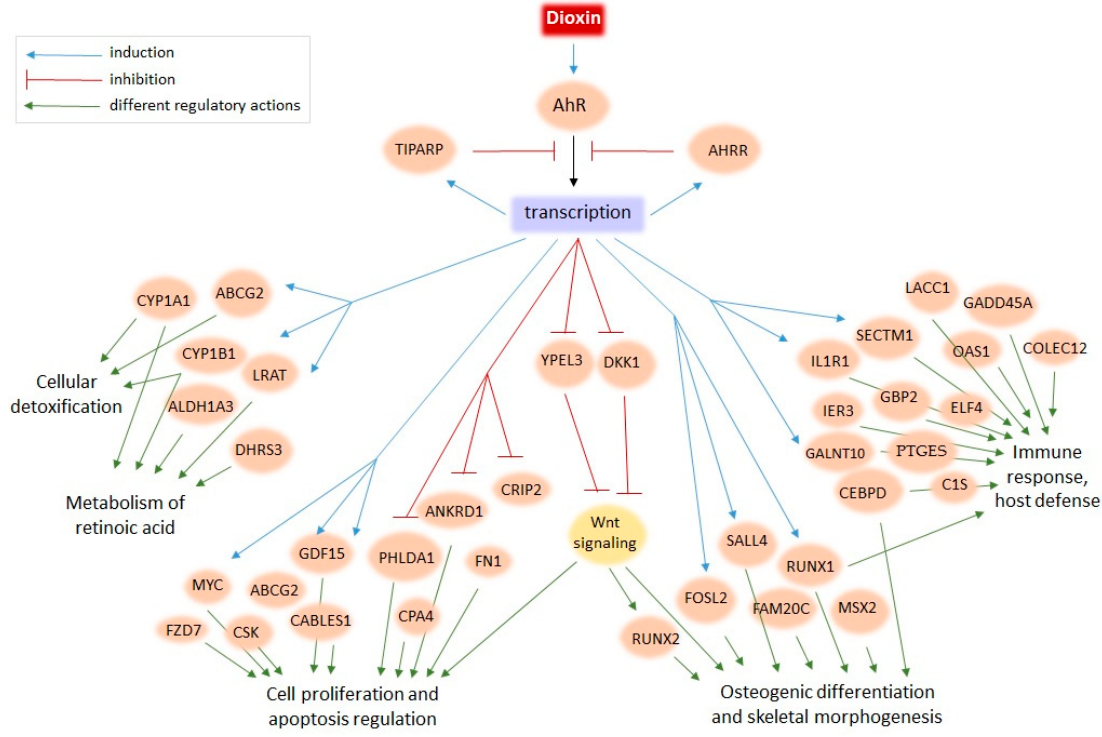
Figure 4. The model of dioxin action on human cells based on the present meta-analysis of transcriptome data.